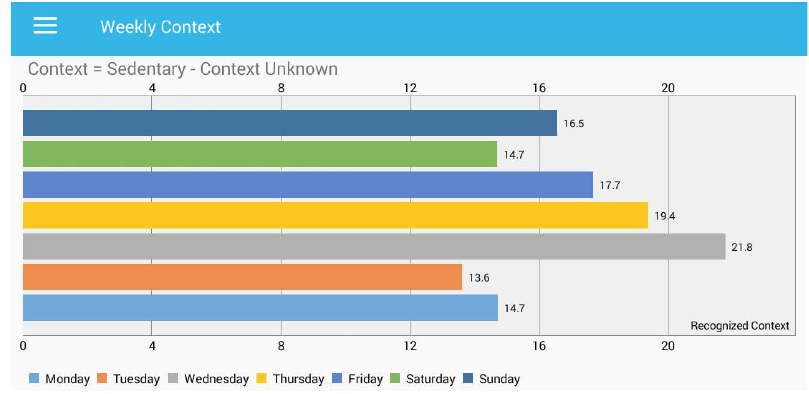
Figure 14. Total time spent during a week for “sedentary-context unknown”.